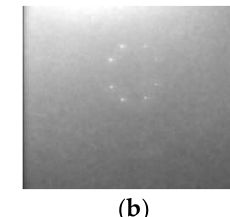
Figure 8. Red and green components of the guidance image: ( a ) red component; ( b ) green com- ponent.